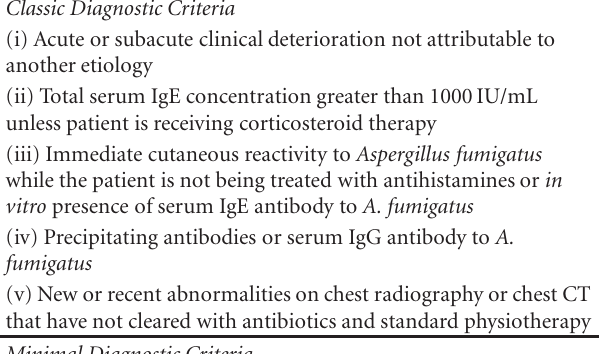
Table 1: Criteria for diagnosis of allergic bronchopulmonary aspergillosis in asthma.